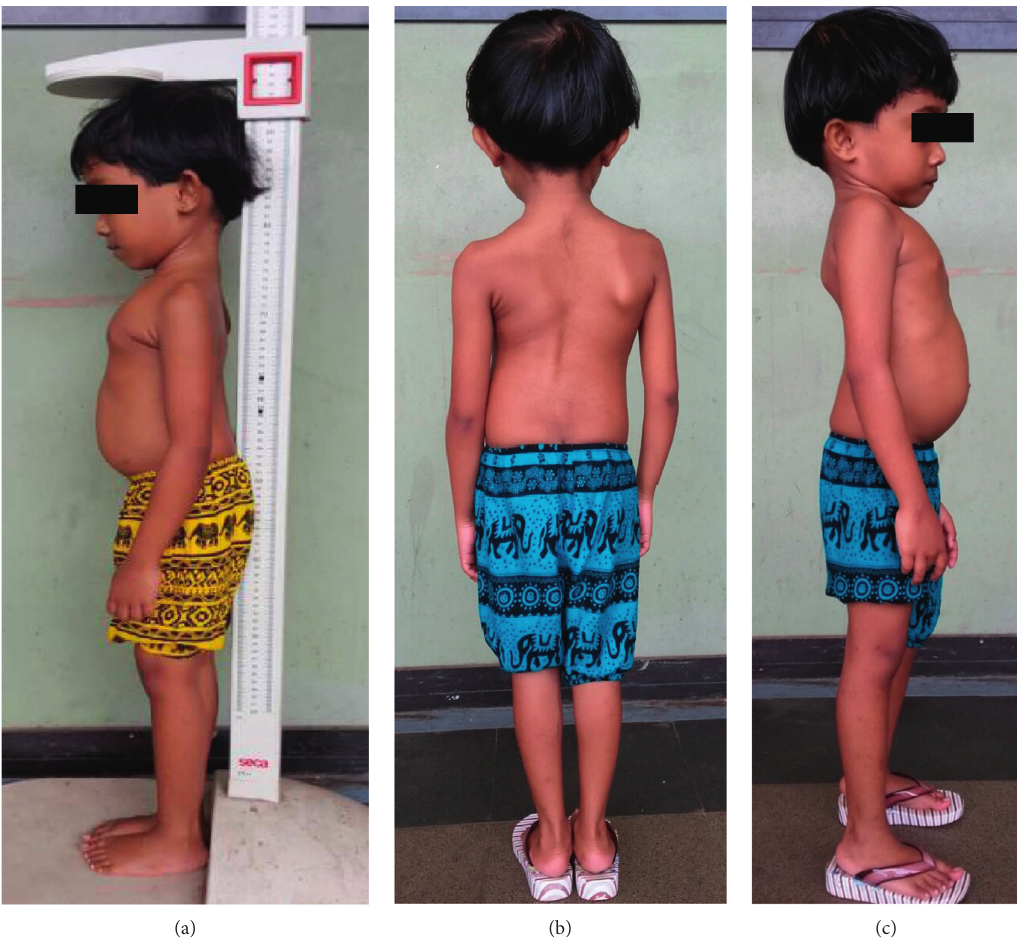
Figure 1: Photographs showing short stature (a), scoliosis (b), and lumbar lordosis